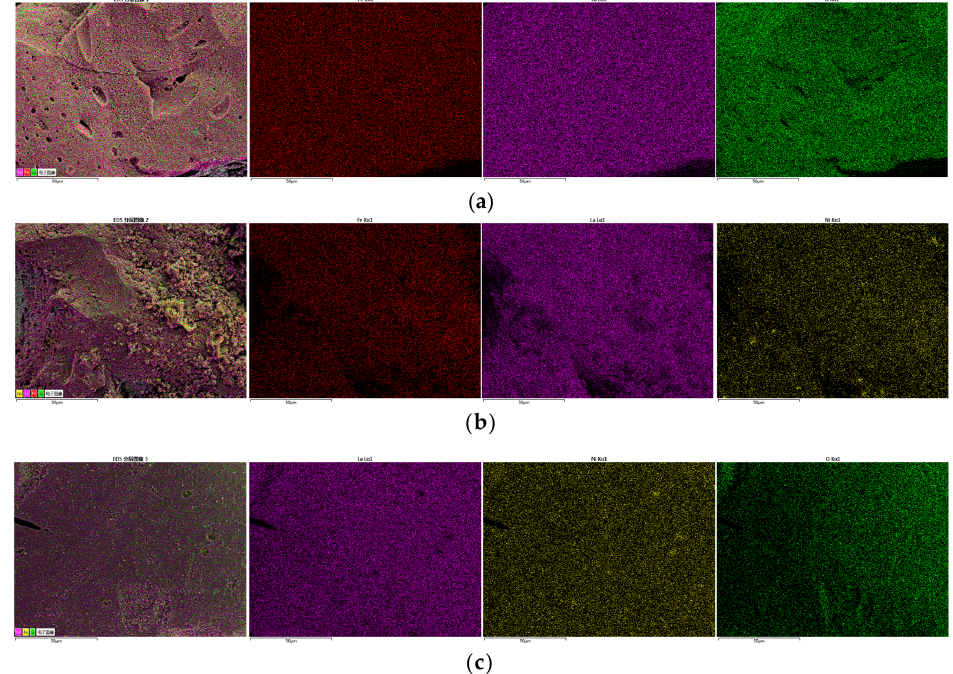
Figure 7. EDS mapping of main elements of oxygen carriers: ( a ) LaFe, ( b ) LaFe 1-x Ni x and ( c ) LaNi. The Ni addition in LaFe (LaFe 1-x Ni x ) would change the phase patterns of oxygen carriers and the results were shown in Figure 8. For the LaFe oxygen carrier (x = 0), the perovskite phase of LaFeO 3 was the only observable compound, and it would exhibit a lower full oxidation reactivity during toluene conversion. Therefore, negligible CO 2 was formed when LaFe was used, as is shown in Figure 4. With x increased from 0.2 to 0.8, some LaFe 0.9 Ni 0.1 , La 2 O 3 , and NiO gradually appeared in addition to LaFeO 3 , and La 4 Ni 3 O 10 was formed when x > 0.6. It indicates that excessive Ni addition would initiate complex competitive reactions, depending on Ni amount. Excessive Ni addition cannot be embedded into the perovskite structure of LaFeO 3 but resulted in NiO. For the LaNi (x = 1) oxygen carrier, the mixed oxides of NiO and La 4 Ni 3 O 10 rather than single perovskite were formed, and they would initiate the full oxidation of toluene and lower H 2 yield. Figure 8. Phase patterns of LaFe 1-x Ni x oxygen carriers. 3.2.2. Effect of Ni Substitution on Toluene Conversion In this part, the performance of four LaFe 1-x Ni x oxygen carriers was compared with LaFe and LaNi at 900 °C and the results are shown in Figure 9. When x = 0.2 (LaFe 0.8 Ni 0.2 ), the gas products distribution was similar to that for LaFe. With x increasing to 0.4, 0.6, and 0.8, the partial oxidation was somewhat weakened due to less LaFeO 3 , while the initial oxidation of H 2 into H 2 O was enhanced. However, the overall H 2 yield was promoted, and the maximum H 2 concentration (reached about 16%) was higher than that in the cases using LaFe and LaNi oxygen carriers. It should be ascribed to the synergistic effect of Fe and Ni in the oxygen carrier. Although not observed in the present investigation, Fe-Ni alloy could be formed in the oxygen carrier with the phase change of oxygen carrier